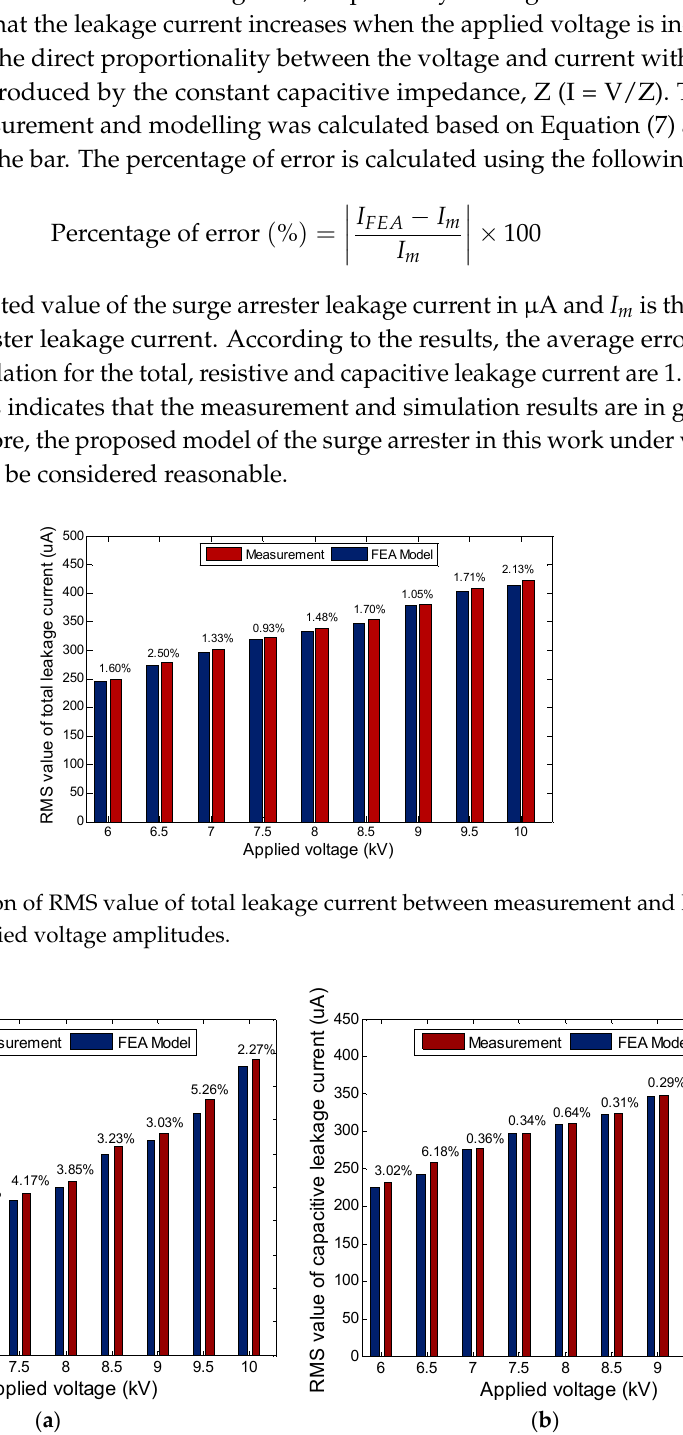
Figure 7. Comparison of RMS value of ( a ) resistive; ( b ) capacitive leakage current between measurement and FEA model under different applied voltage amplitudes.